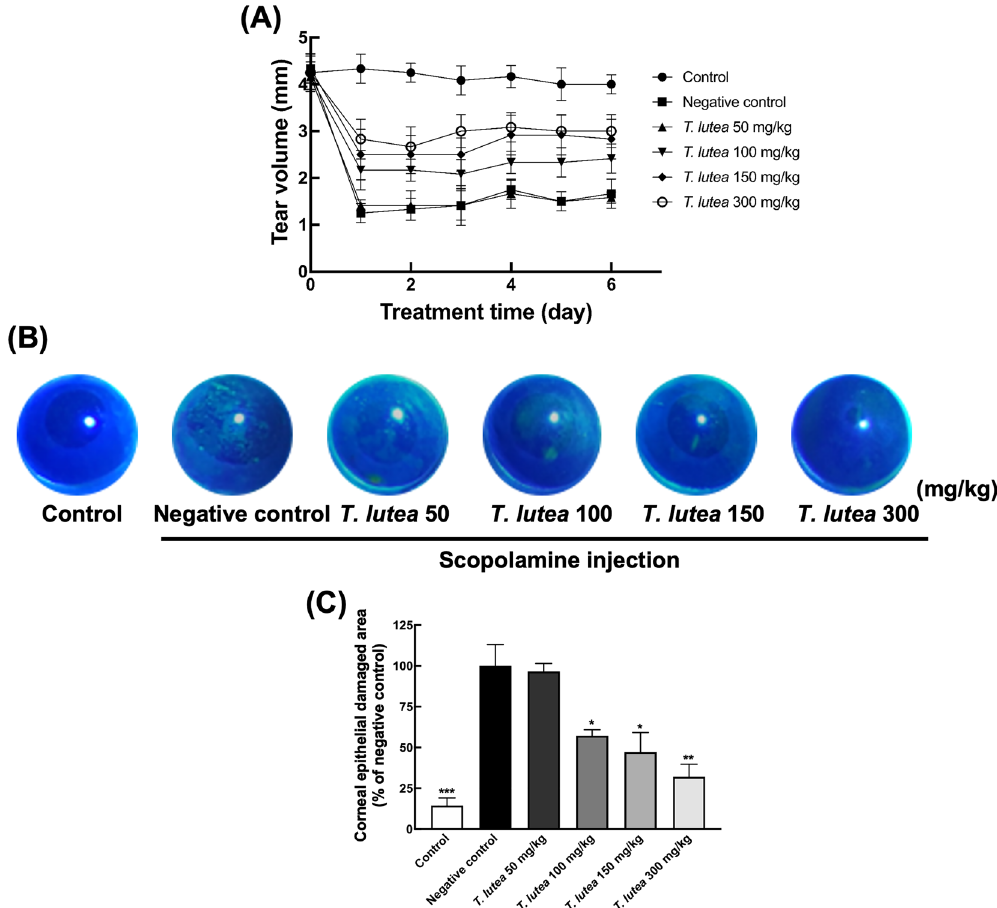
Figure 1. Effects of T. lutea on eye damage and tear production. Dry eye (DE) was induced by scopolamine injection, and T. lutea was administered at concentrations of 0 (control; CON, without DE induced by scopolamine injection), 50 ( T. lutea 50), 100 ( T. lutea 100), 150 ( T. lutea 150), or 300 (AKE 300) mg/kg. ( A ) Tear volume was measured using Schimer’s test. ( B ) Representative images of corneal fluorescein staining. ( C ) Quantitative analysis of images in ( B ). Each treatment group consisted of 7 mice (n = 14 eyes). Data are represented as mean ± SEM (error bar). * p < 0.05, ** p < 0.01, and *** p < 0.001 versus negative control. Data were analyzed statistically using one-way ANOVA followed by Tukey’s post hoc